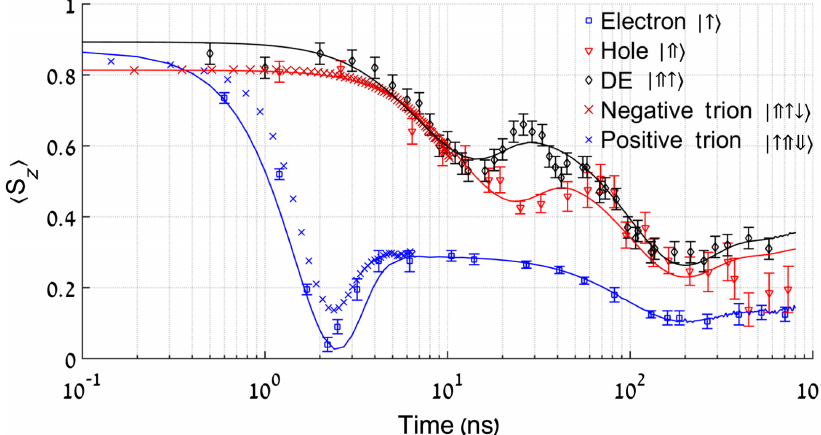
FIG. 4. Measured central spin polarization h S as a function of time after its initialization, for the QD confined electron (blue square z i symbols), heavy hole (red triangle symbols), dark exciton (black diamond symbols), negative trion (red times symbols), and positive trion (blue times symbols). Error bars represent one standard deviation of the experimental uncertainty. Solid color-matched lines represent the fitted theoretical model (see Appendices), for each case. The spin wave functions are schematically described in the legend, where the notations of Fig. 1 are